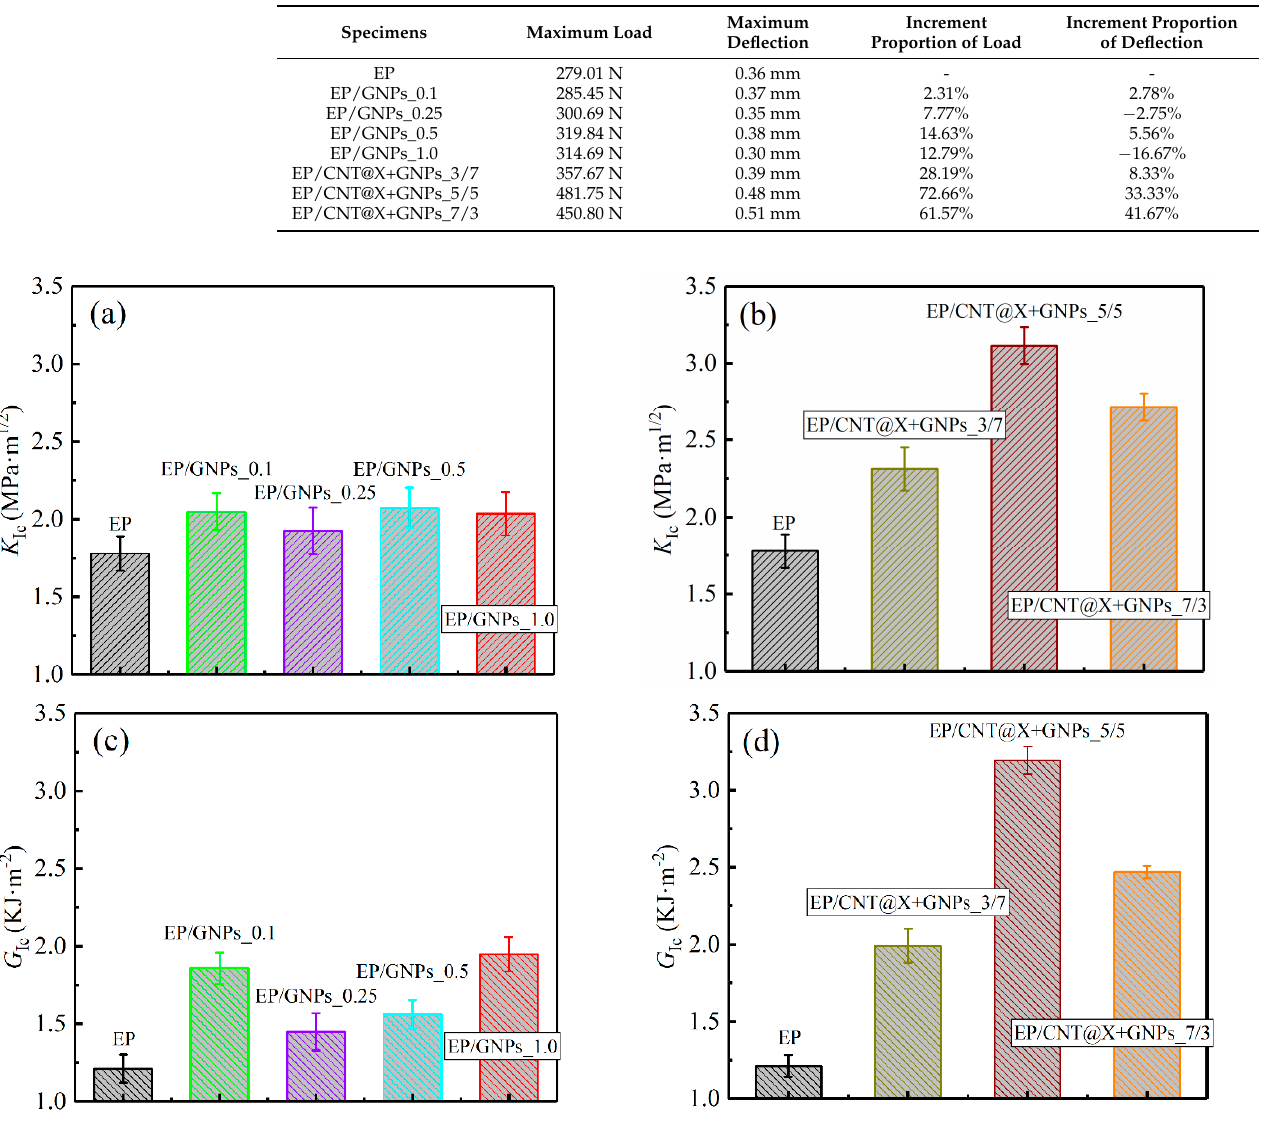
Table 4. Quasi-static mechanical properties of the EP/GNPs and EP/CNT@X+GNPs nanocomposite specimens.